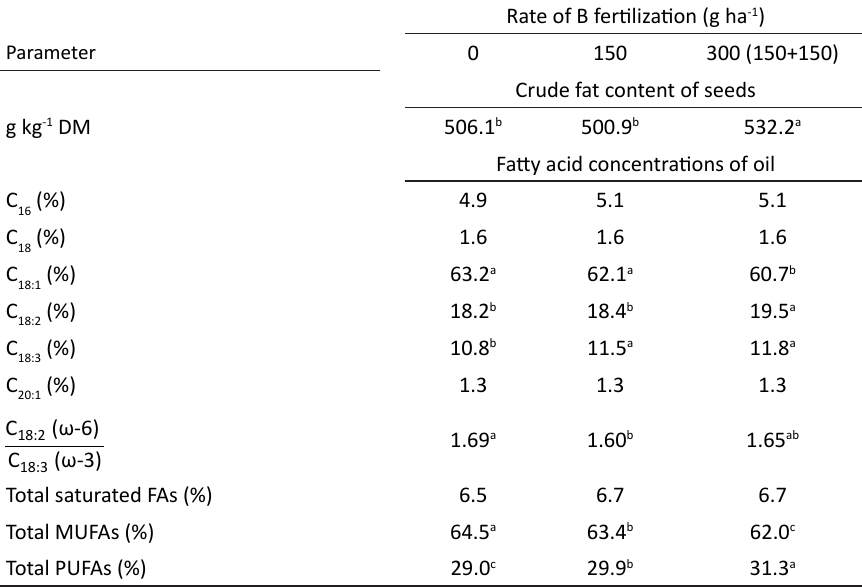
Table 7. Influence of foliar application of B on the nutritional value of seeds of winter oilseed rape (across